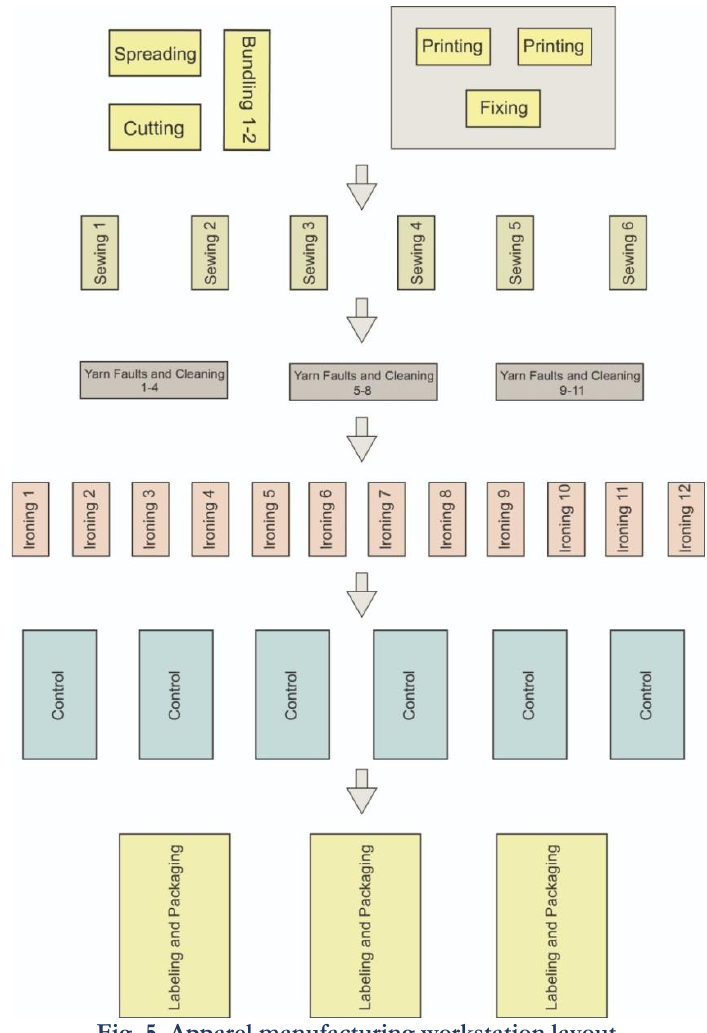
Fig. 5. Apparel manufacturing workstation layout.